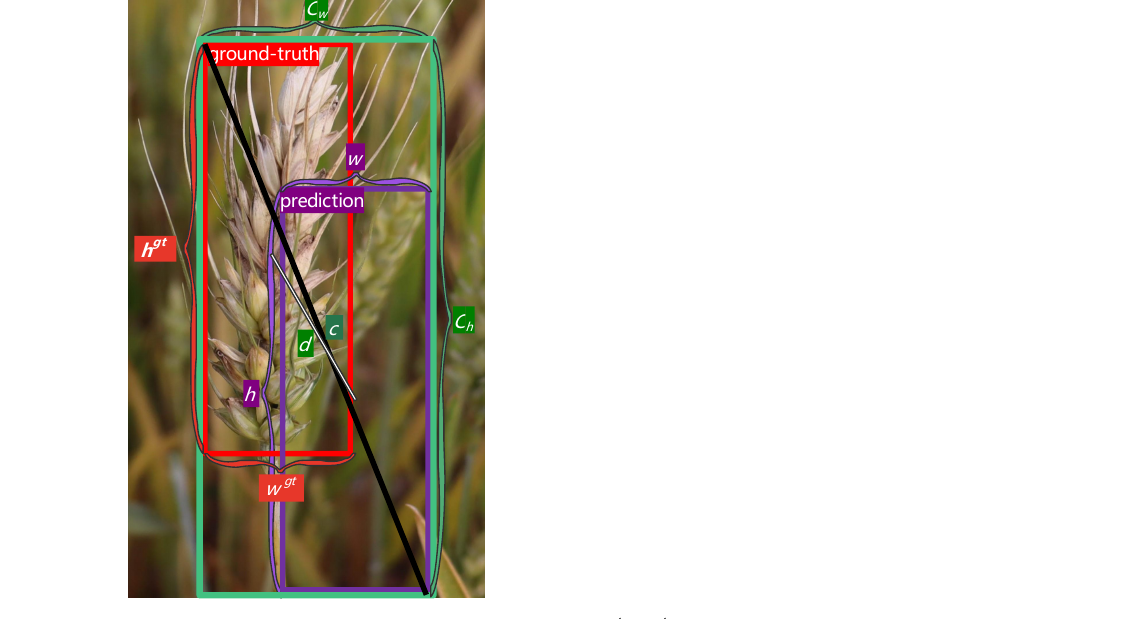
Figure 3. The EIoU loss for box regression. The h gt , w gt , w , h , C w , C h , d , and c are the same definition as Equation (6).